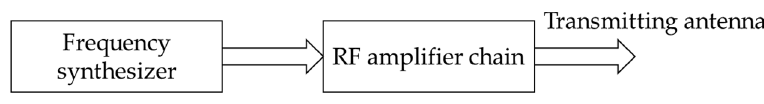
Figure 3. Simplified structure block diagram of radar transmitter.